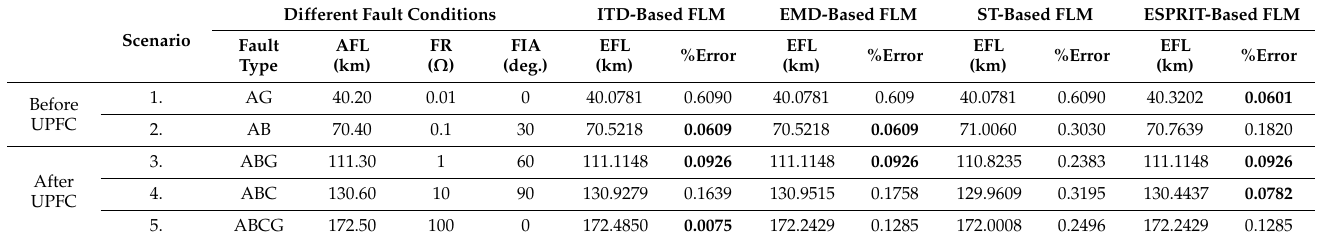
Table 3. Performance under series-shunt compensation (mid-point connected UPFC).